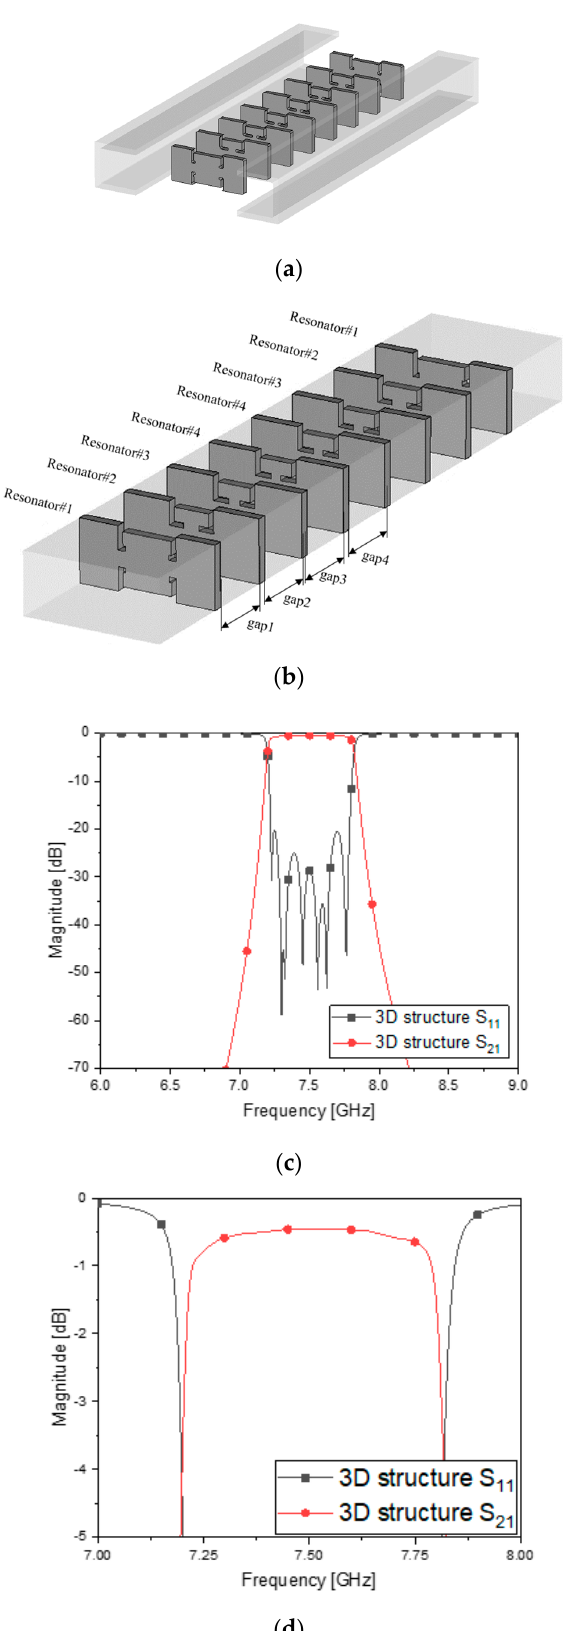
Figure 6. Combining eight ZORs through the gaps for coupling. ( a ) and ( b ), structure. ( c ) S 11 and S 21 . ( d ) S 11 and S 21 zoomed − in.